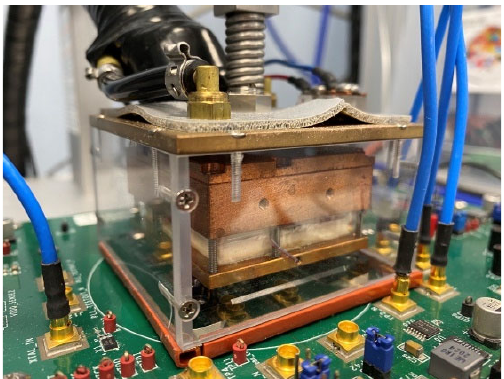
Figure 2. Commercial thermal control solution in Silicon Creations Laboratory.